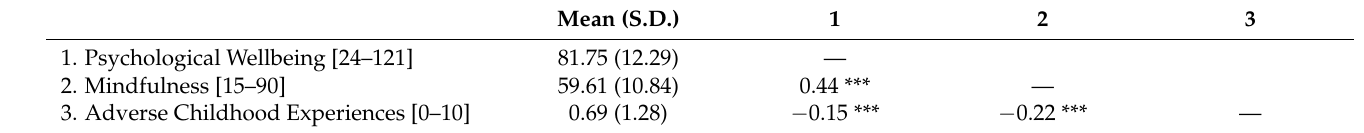
Table 1. Descriptive statistics and correlations of key variables.